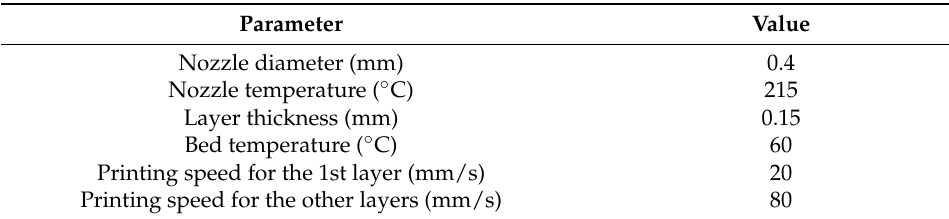
Figure 1. 3D model of smart irrigation prototype ( a ) and a 3D model reconstruction obtained from X-ray tomography analysis of the permeable part 3D printed at different ID percentage ( b ). Table 3. 3D printing process parameters.